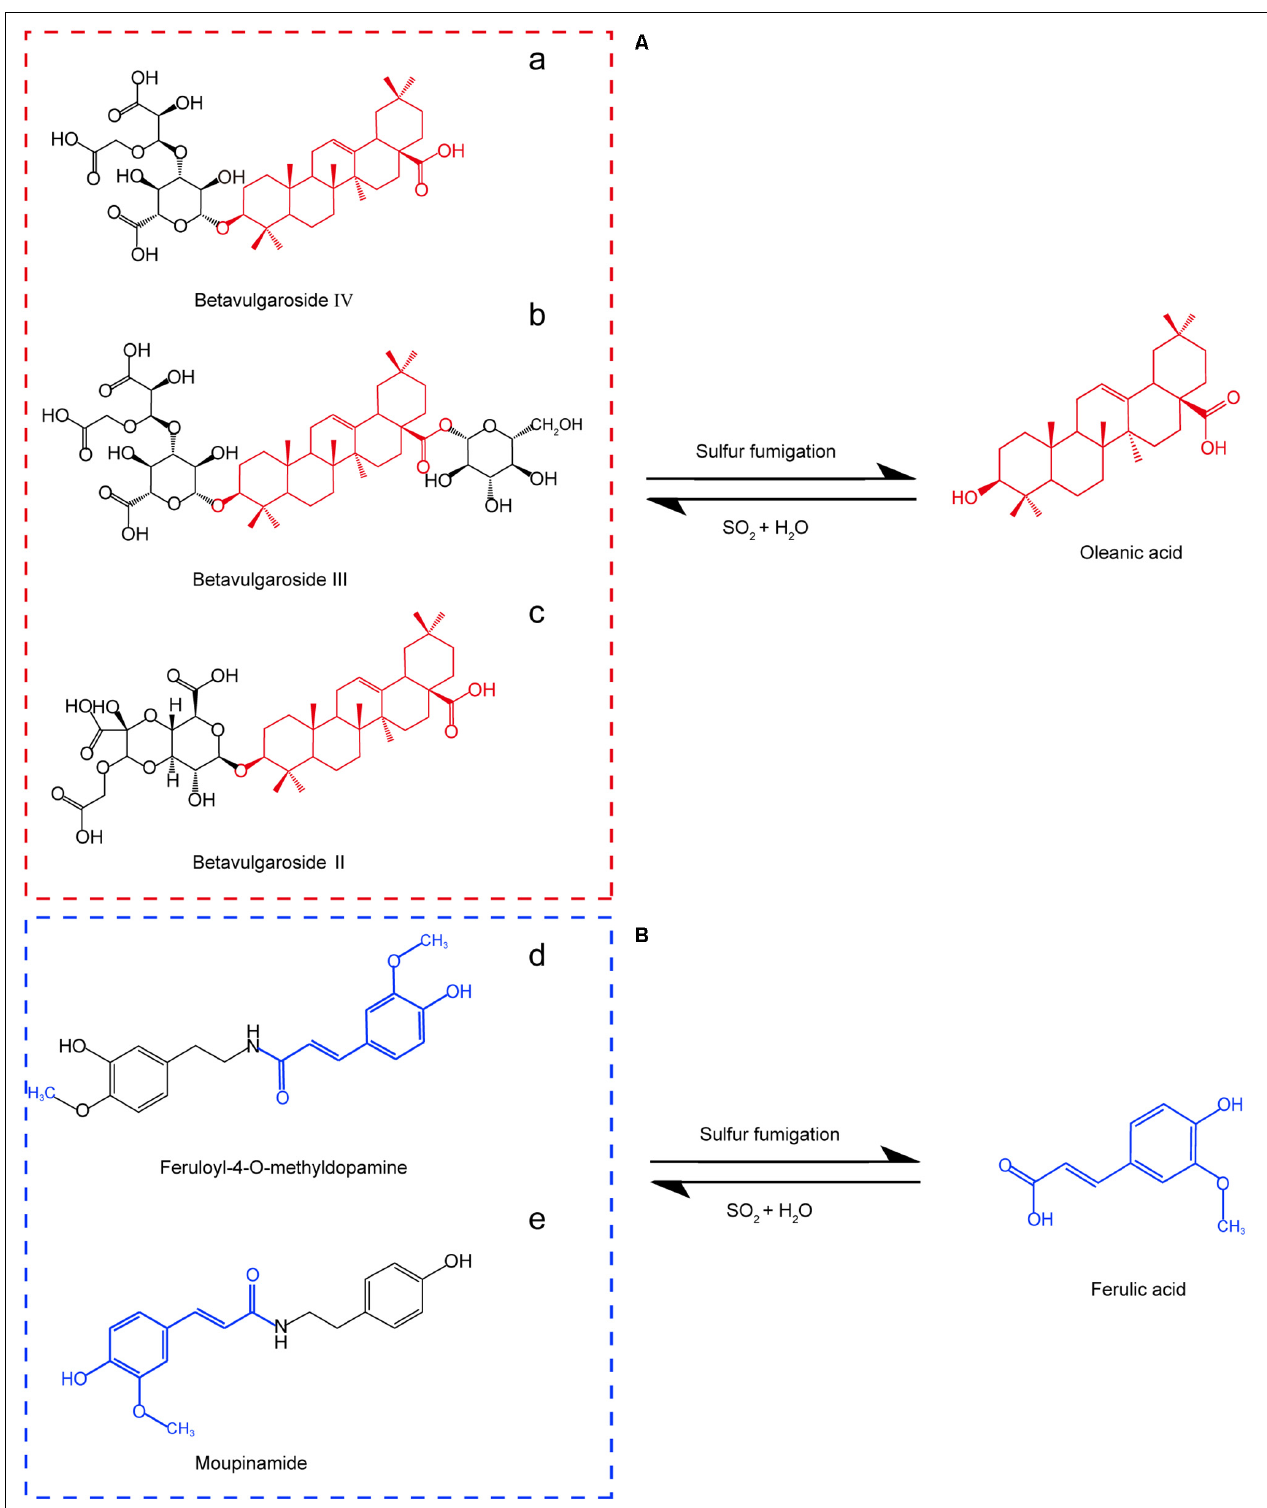
FIGURE 4 | Five characteristic chemical markers and transformation of sulfur-fumigated AB. (A) The intensity of three markers (a, b. and c) declined after sulfur-fumigation; (B) the intensity of two markers (d and e) increased after sulfur-fumigation.